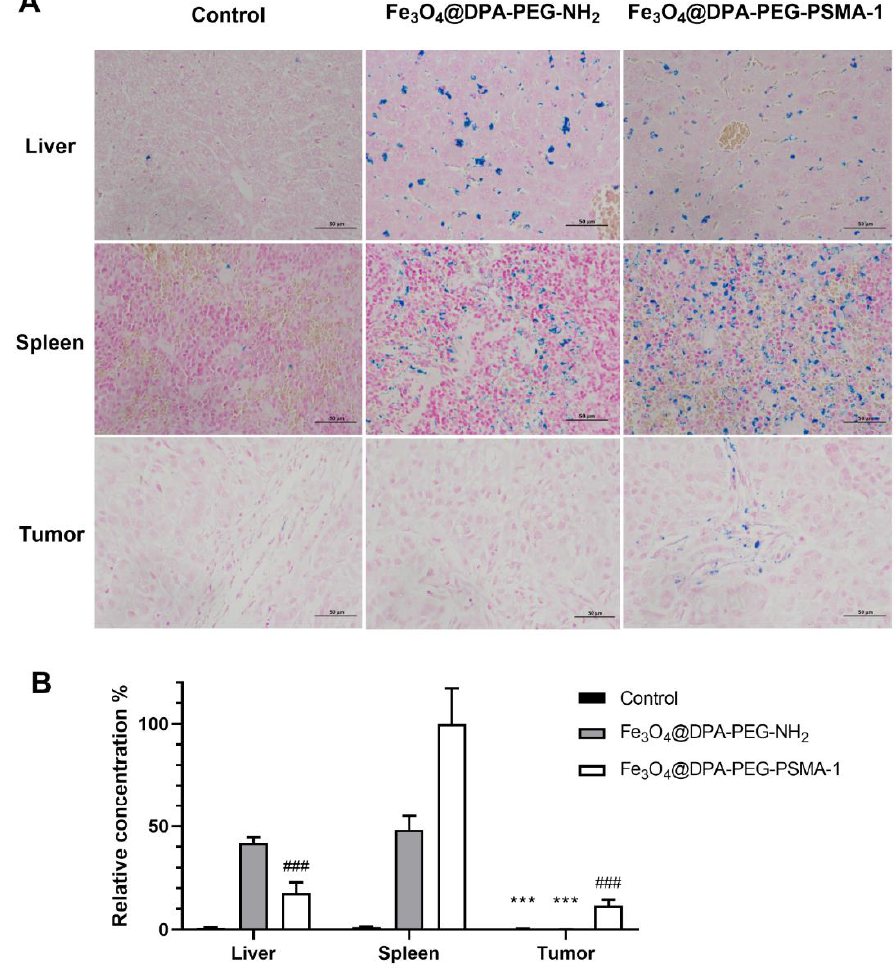
Figure 6. ( A ) Prussian blue and nuclear fast red double staining images of liver, spleen, and tumor tissues of Control group, Fe 3 O 4 @DPA-PEG-NH 2 group and Fe 3 O 4 @DPA-PEG-PSMA-1 group 24 h after single-dose injection of PSMA-targeted and non-targeted SPIONs (Fe, 20 mg/kg) in PCa xenografted nude mice. Scale bars equal 50 μm. ( B ) Semi-quantification of relative concentration of SPIONs in liver, spleen, and tumor tissues of each group. Data are presented as means ± SD. Compared with Fe 3 O 4 @DPA-PEG-PSMA-1 in tumor tissue, *** p < 0.001. Compared with Fe 3 O 4 @DPA-PEG-PSMA-1 in spleen tissues, ### p < 0.001. N = 6 per group.